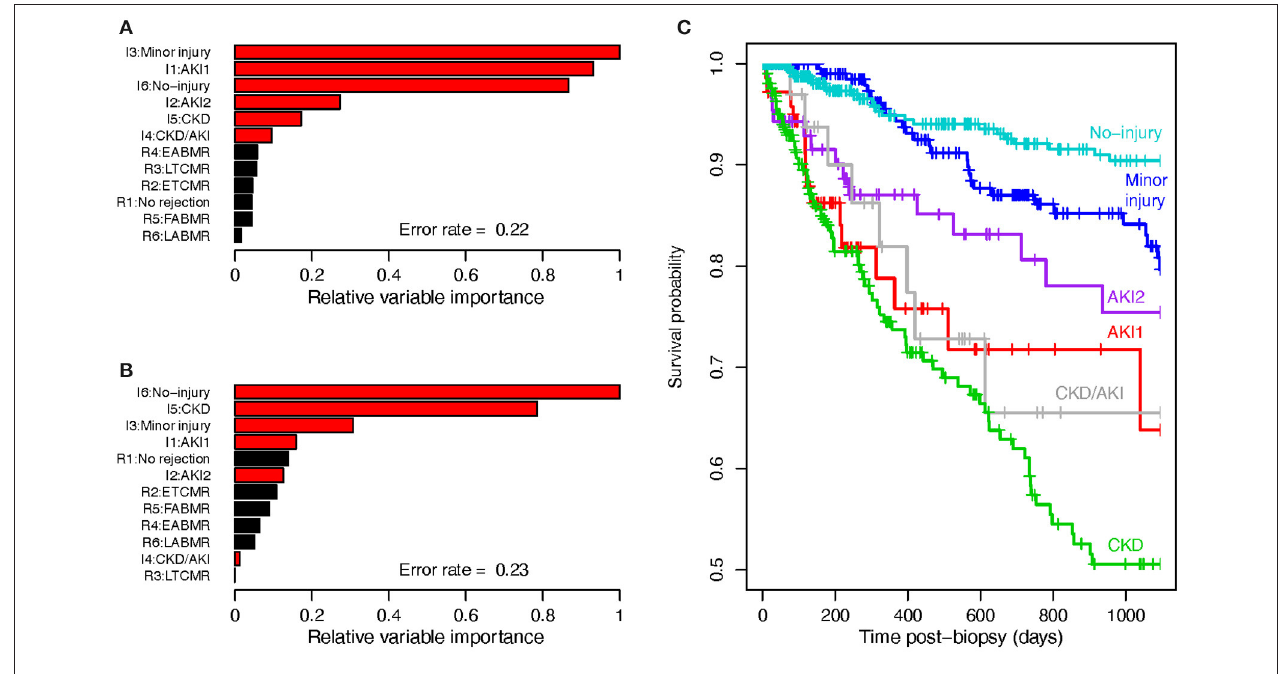
FIGURE 2 | Graft survival analyses. (A) Random forests assessing variable importance in predicting low eGFR (eGFR < 30). (B) Random forests assessing variable importance in predicting 3-year death-censored graft survival. (C) Kaplan-Meier curves showing 3-year post-biopsy actuarial survival in the six AA injury archetype